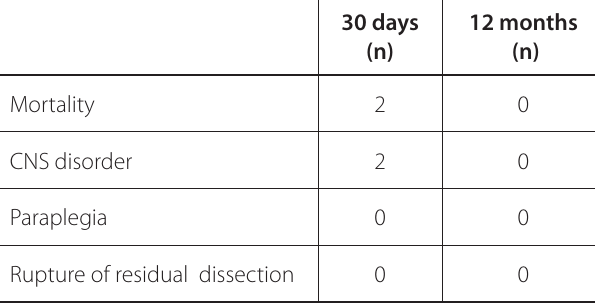
Table 6 . Post-reoperative outcomes.